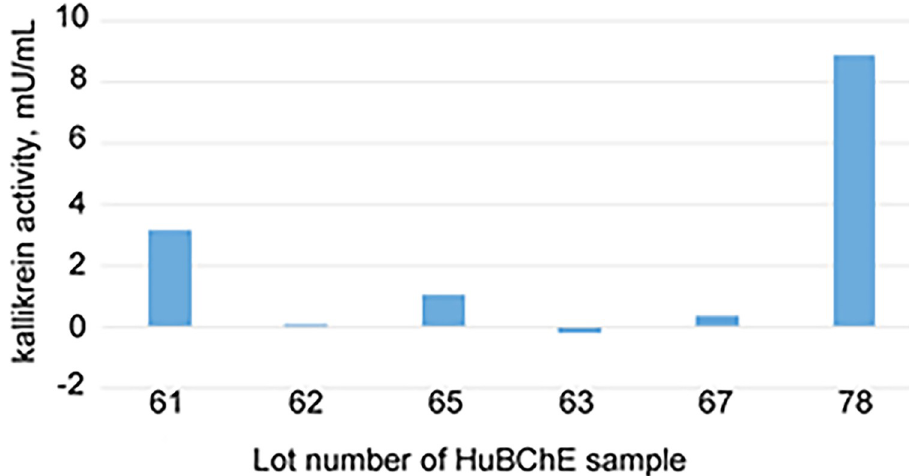
Fig 6. Kallikrein activity in Hupresin-purified BChE preparations. In a previous report we showed that human BChE hydrolyzes the chromogenic substrate used for measuring endotoxin concentration, Ac-Ile-Glu-Ala-Arg-p- nitroanilide [8]. The peptide substrate in the endotoxin assay is similar to that in the kallikrein activity assay (S-2302), but we found that BChE does not hydrolyze